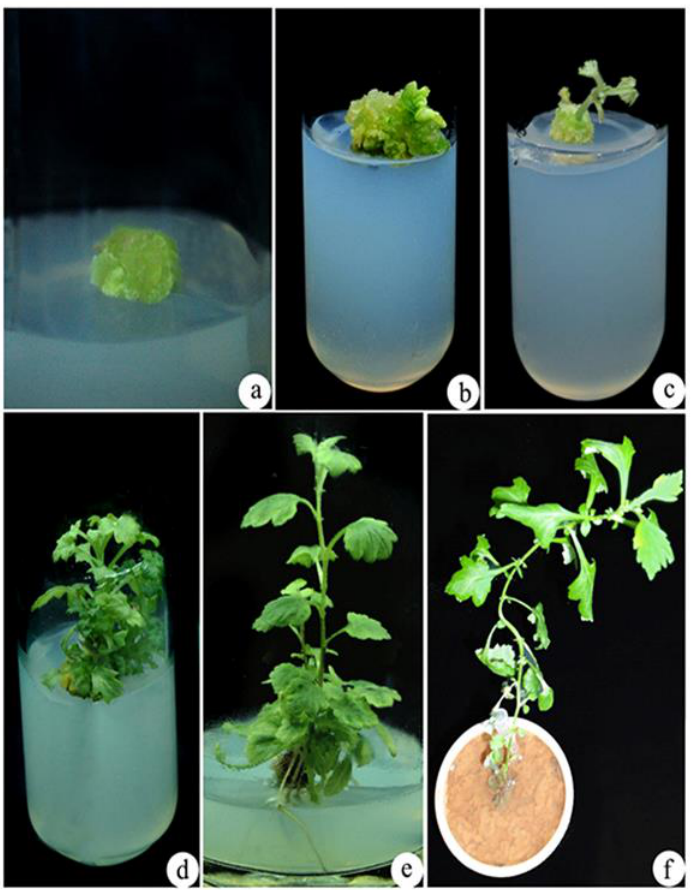
Figure 2. In vitro regeneration of A. vulgaris from control callus (0 mM NaCl stress). ( a ) Regenerated callus from nodal explants, ( b , c ) shoot induction from the callus, ( d )multiple shoots proliferation, ( e ) elongated shoot with roots, ( f ) hardened plant in the cup.